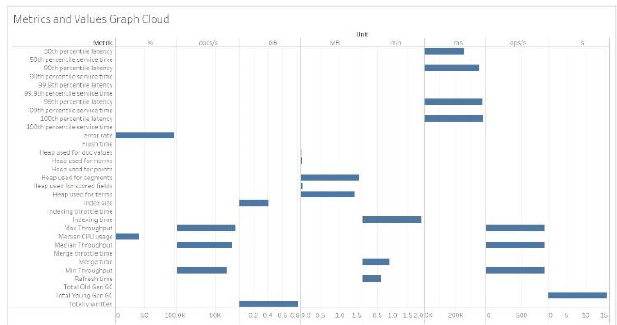
Figure 6. ElasticSearch Cloud Instance Results